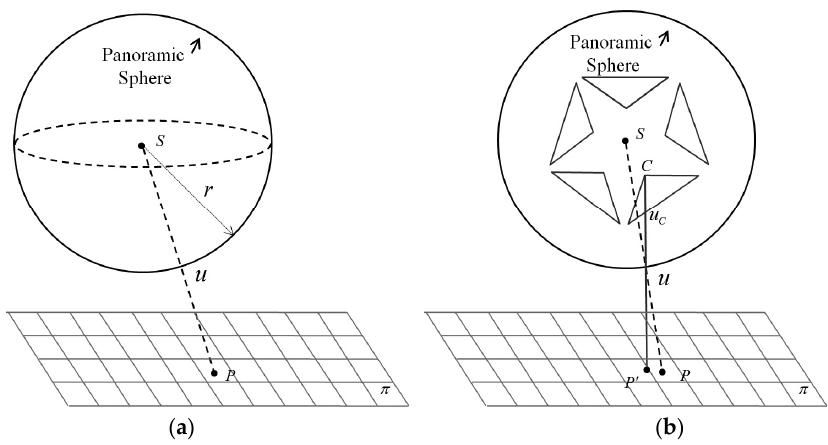
Figure 4. Differences between the spherical and panoramic camera models. ( a ) The dashed line shows the ray through 3D point P , panoramic image point u , and sphere center S ; ( b ) the solid line shows the ray through 3D point P ′ , mono-camera image point u c , panoramic image point u, and the mono- camera projection center C .